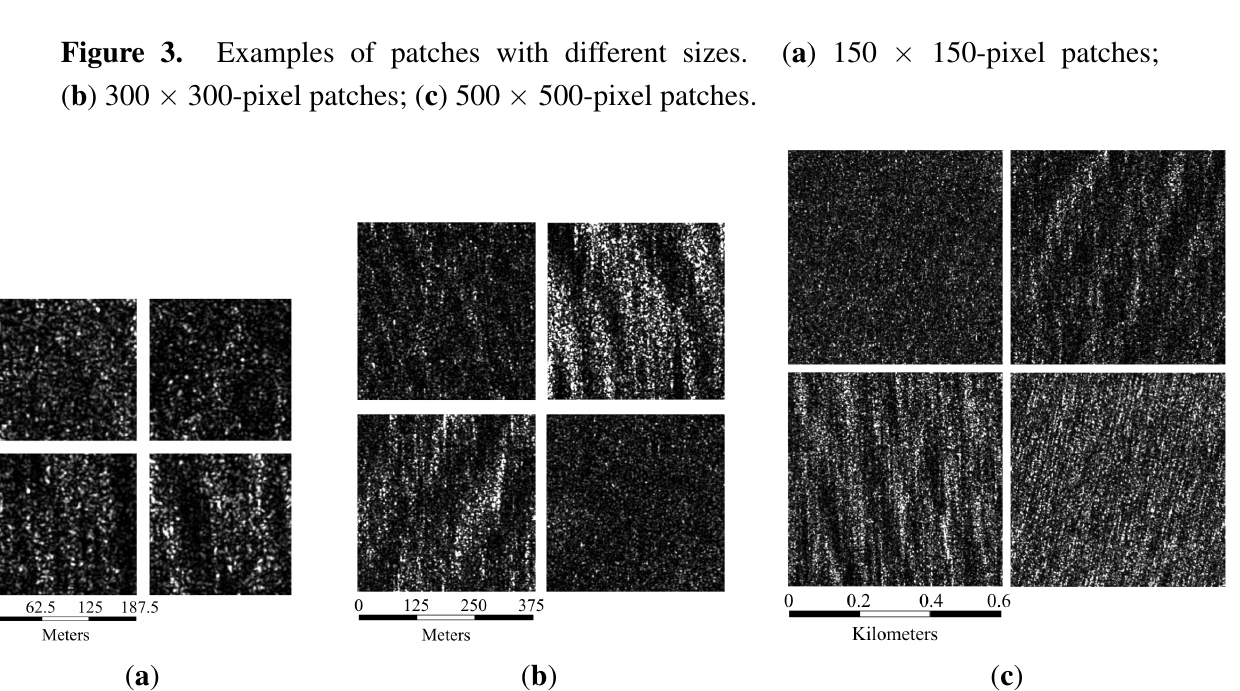
Figure 3. Examples of patches with different